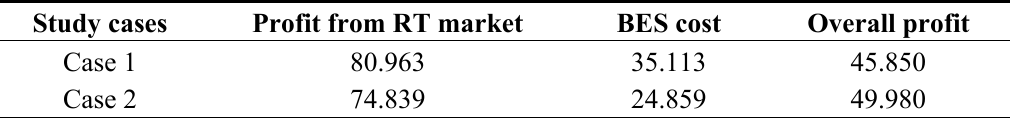
Table 1. Comparison of the economic results between two